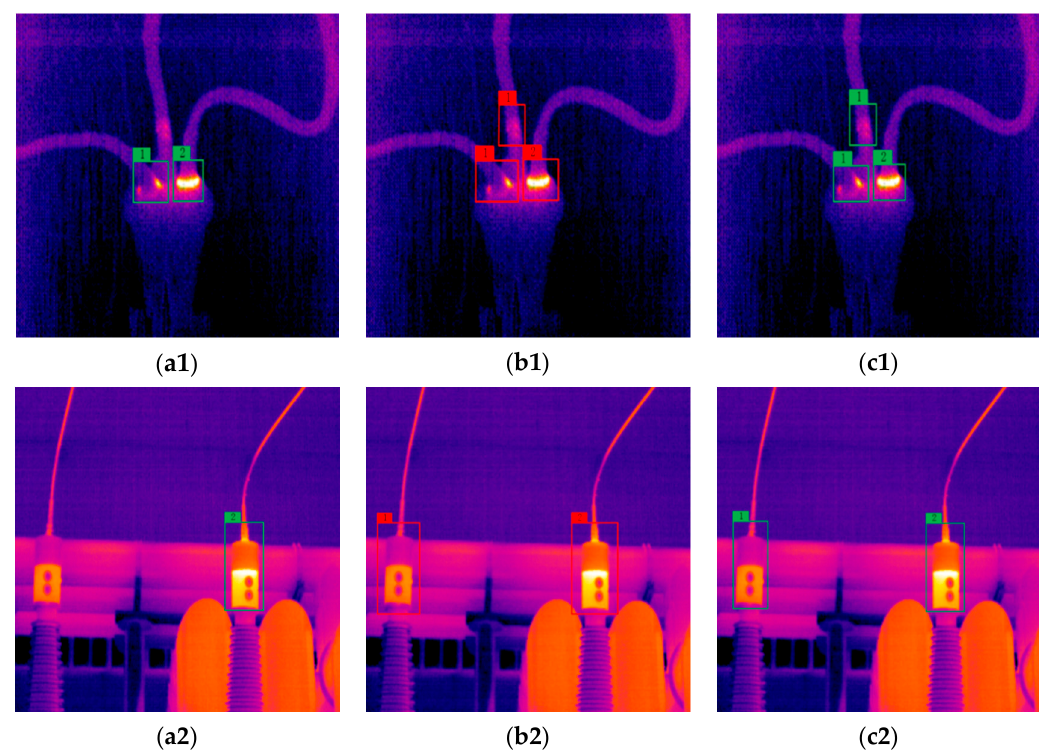
Figure 11. The detection results of three network models: ( a1 , a2 ) YOLOv3; ( b1 , b2 ) Faster region-based convolutional neural network (R-CNN); ( c1 , c2 ) D-YOLOv3.